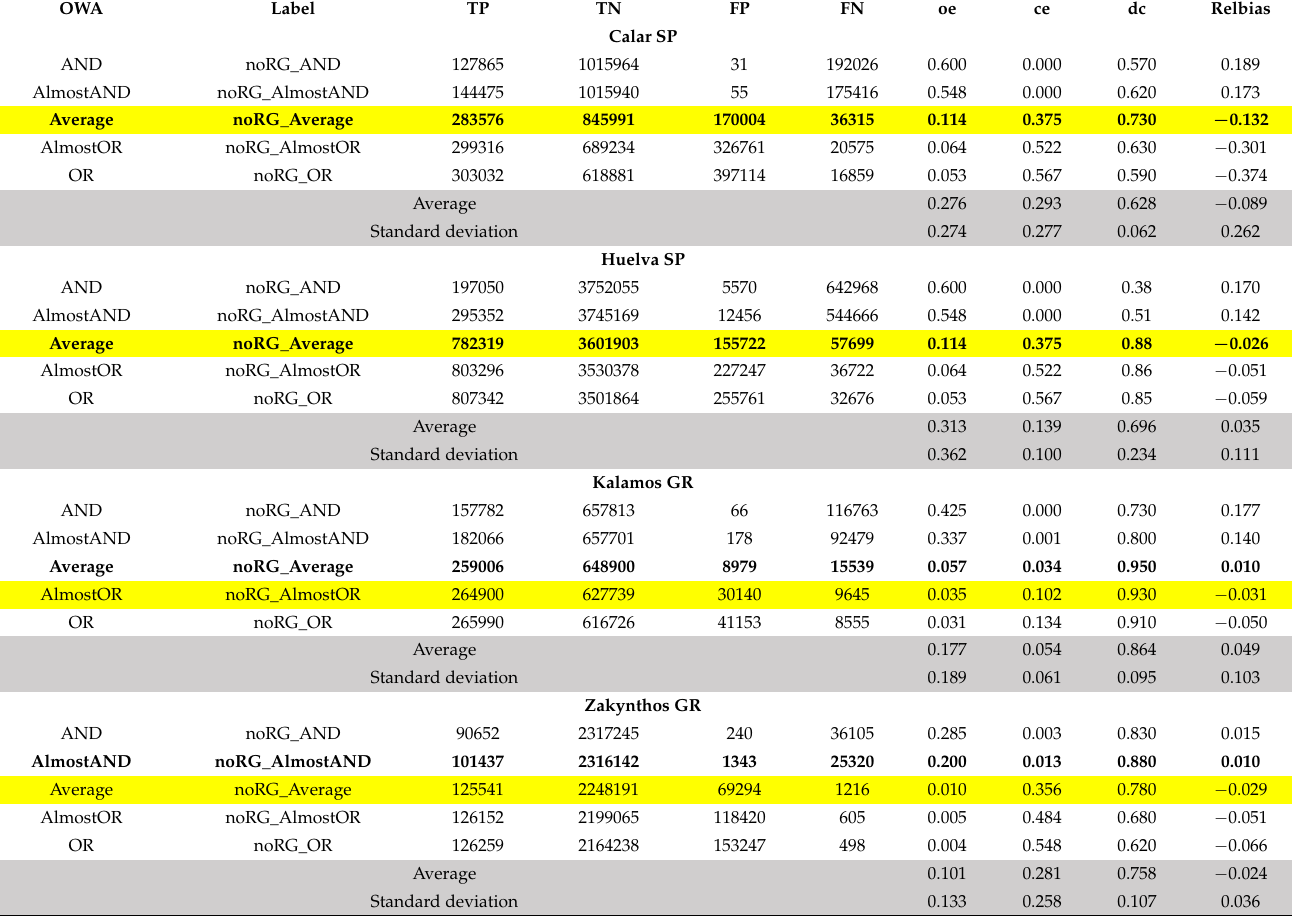
Table A2. Confusion matrices (TP = true positive, TN = true negative, FP = false positive, FN = false negative) and the metrics (omission error = oe, commission error = ce, Dice coefficient = dc, relative bias = relbias) for the OWA layers used for mapping Bas without RG algorithm. Labels are the same displayed in Figure